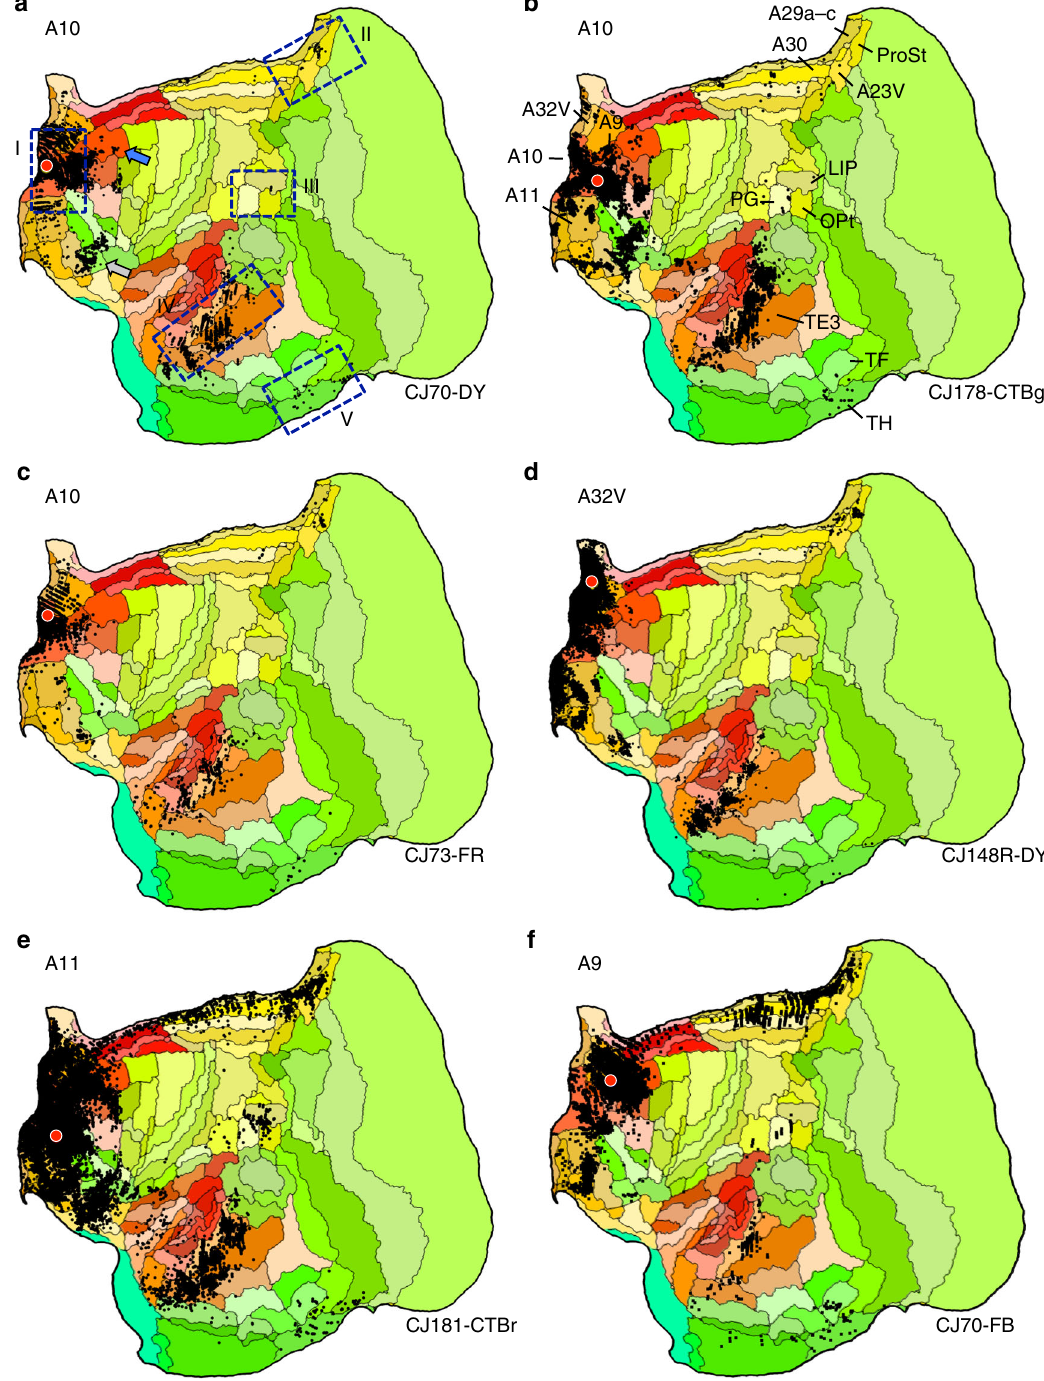
Fig. 3 Anatomical evidence for an apex transmodal network in the marmoset. a – f Multiple injections from frontopolar cortex A10 and adjacent areas are illustrated. The blue bounding boxes in a identify fi ve target zones hypothesized to be part of the default network-A, labeled I – V. The area labels in b are displayed for key areas useful for orienting to components of default network-A. The blue arrow in a notes projections originating in A8ab, which is examined in more detail in Fig. 5. The gray arrow in a notes projections within and along the border of A47O/A13L/A13M that are discussed in the text. Arrows also illustrate similar patterns from temporal injections in Fig.